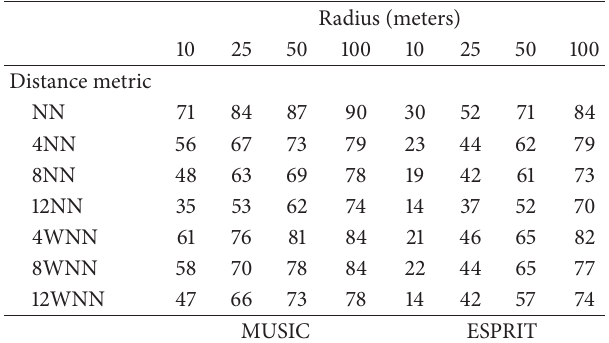
Table 7: Number of “hits” within given radius to actual location for each distance metric out of 100 trials. SNR = 15dB; number of antennas = 8; oversampling factor = 20; distance-threshold = 0.2, Scenario A.